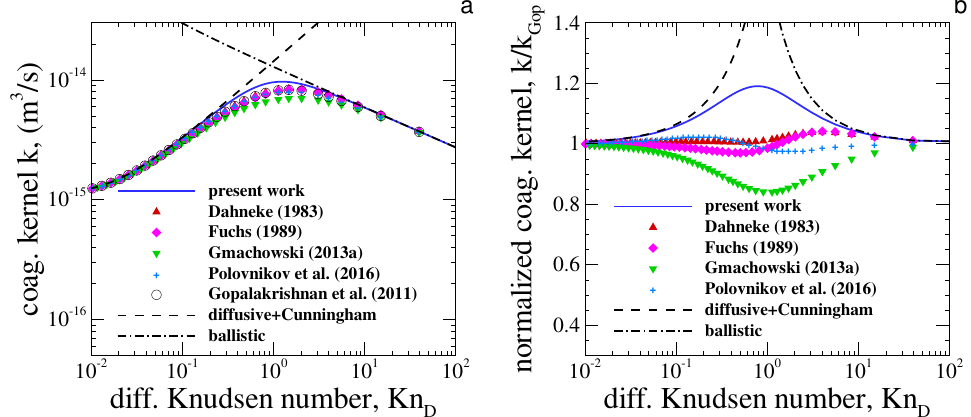
Figure 4. ( a ) Coagulation kernels k as a function of the diffusive Knudsen number Kn D . ( b ) Rel- ative coagulation kernel compared with k Gop proposed by [12]. The proposed method, given by Equation (20) is compared with the literature. Fuchs (1989) [8], Dahneke (1983) [9], Gopalakrish- nan et al. (2011) [12], Polovnikov et al. (2016) [13], Gmachowski (2013a)